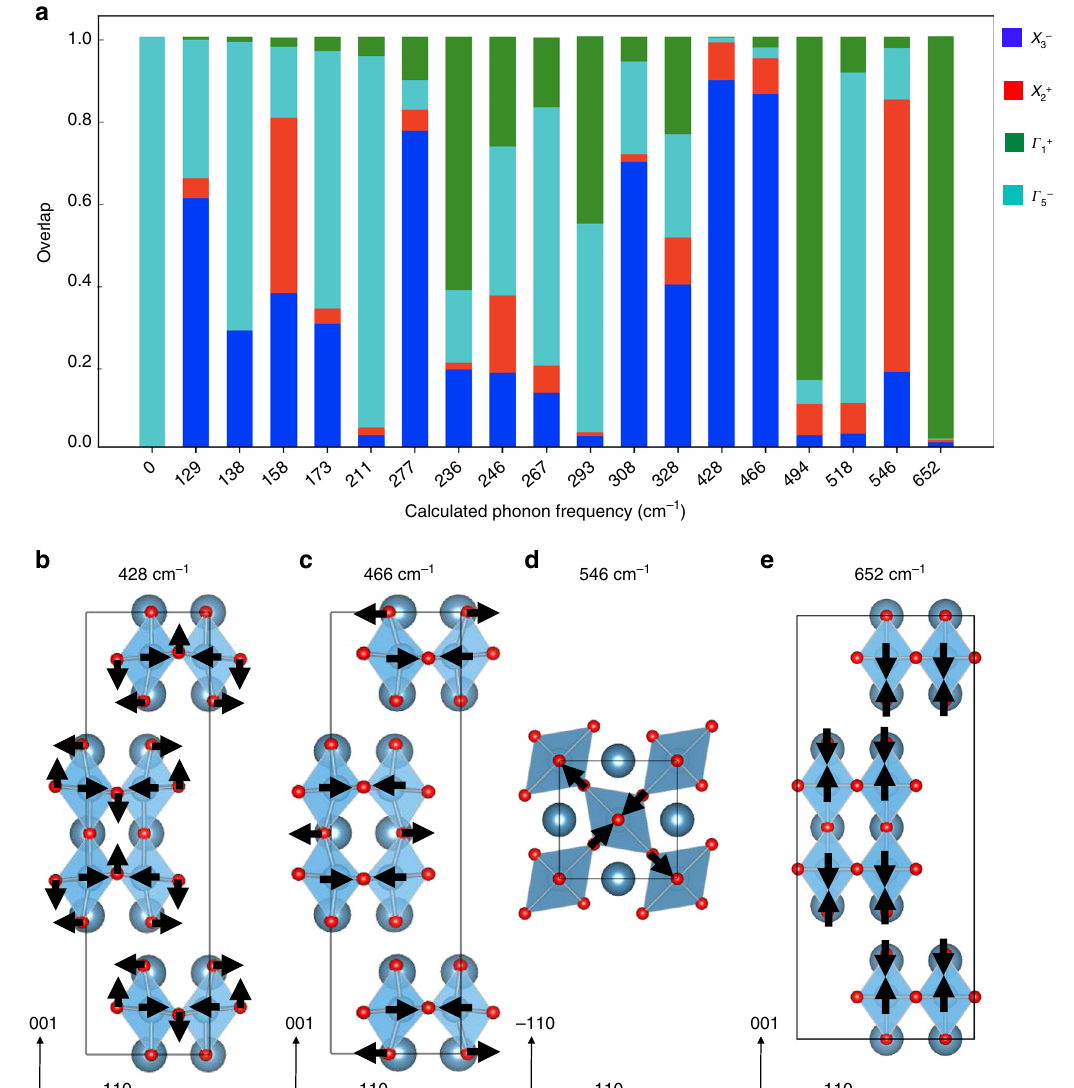
Fig. 4 Phonon overlaps and calculated displacement patterns. a The 19 A 1 symmetry phonon eigenvectors projected onto the I 4 = mmm symmetry-adapted modes. The labels are the calculated phonon frequencies. b – e Atomic displacement patterns of four selected phonons from a . The black arrows display the largest atomic motions within each displacement pattern. The 428 and 466 cm (cid:3) 1 phonons largely consist of Ti-O-Ti bond angle bends. The 546 and 652 cm (cid:3) 1 phonons are bond-stretching modes in the ab plane and along the c -axis,